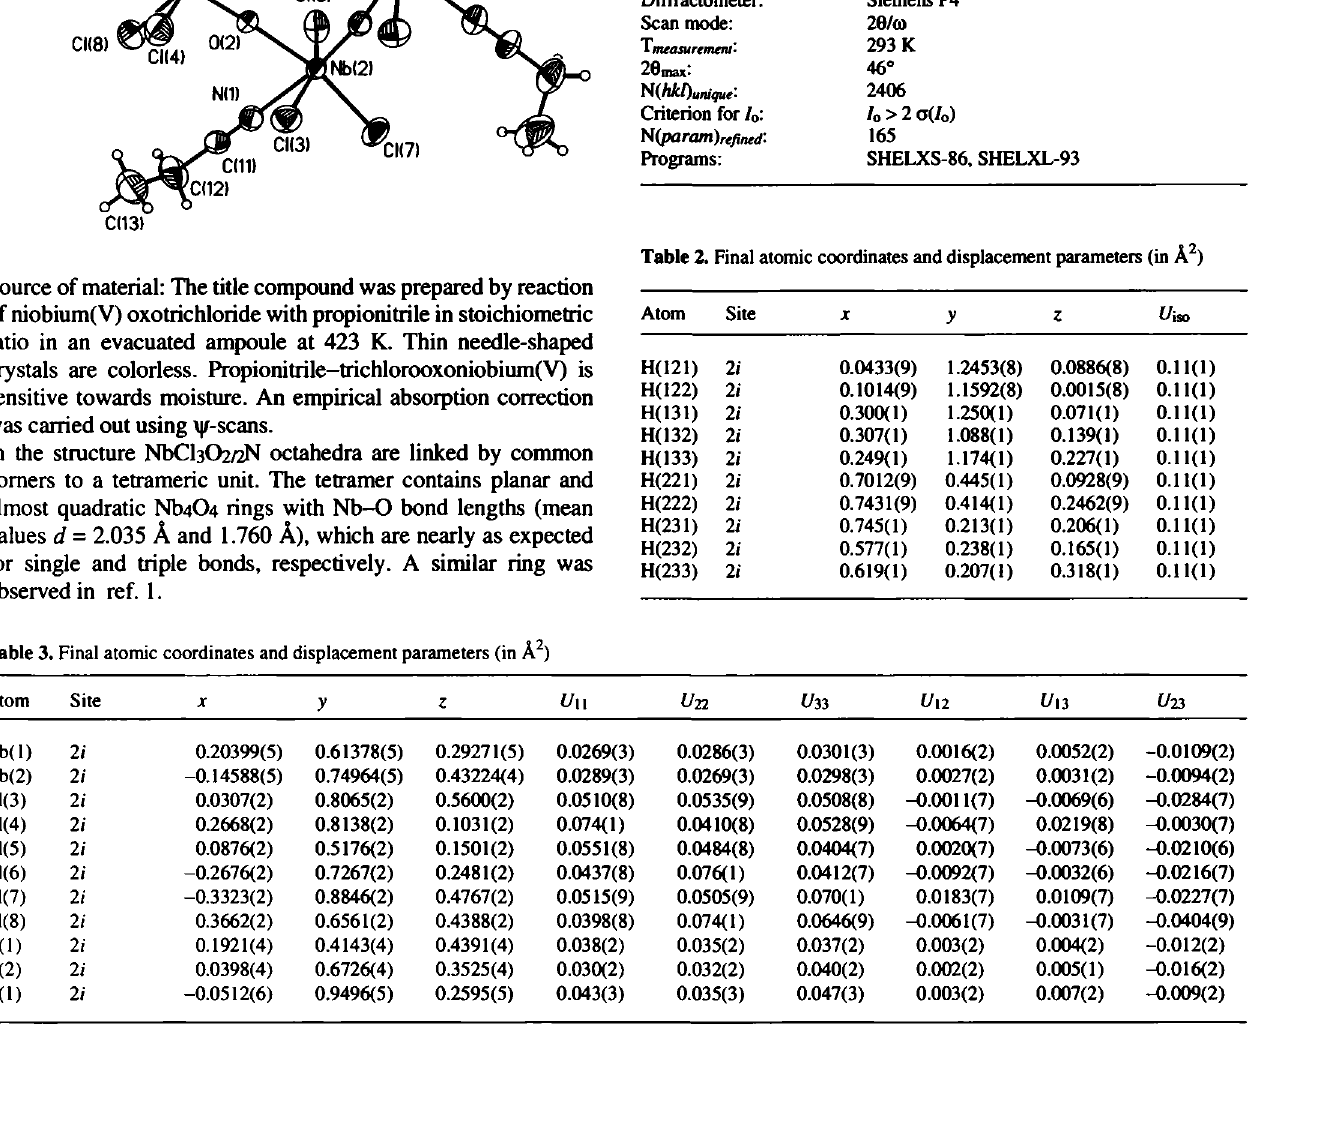
Table 1. Parameters used for the X-ray data collection Crystal: